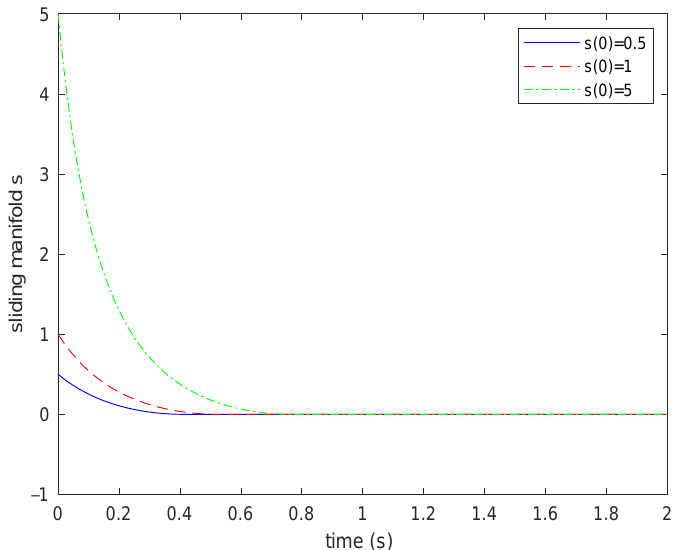
Figure 7. Sliding manifolds with reaching law (35) in Example